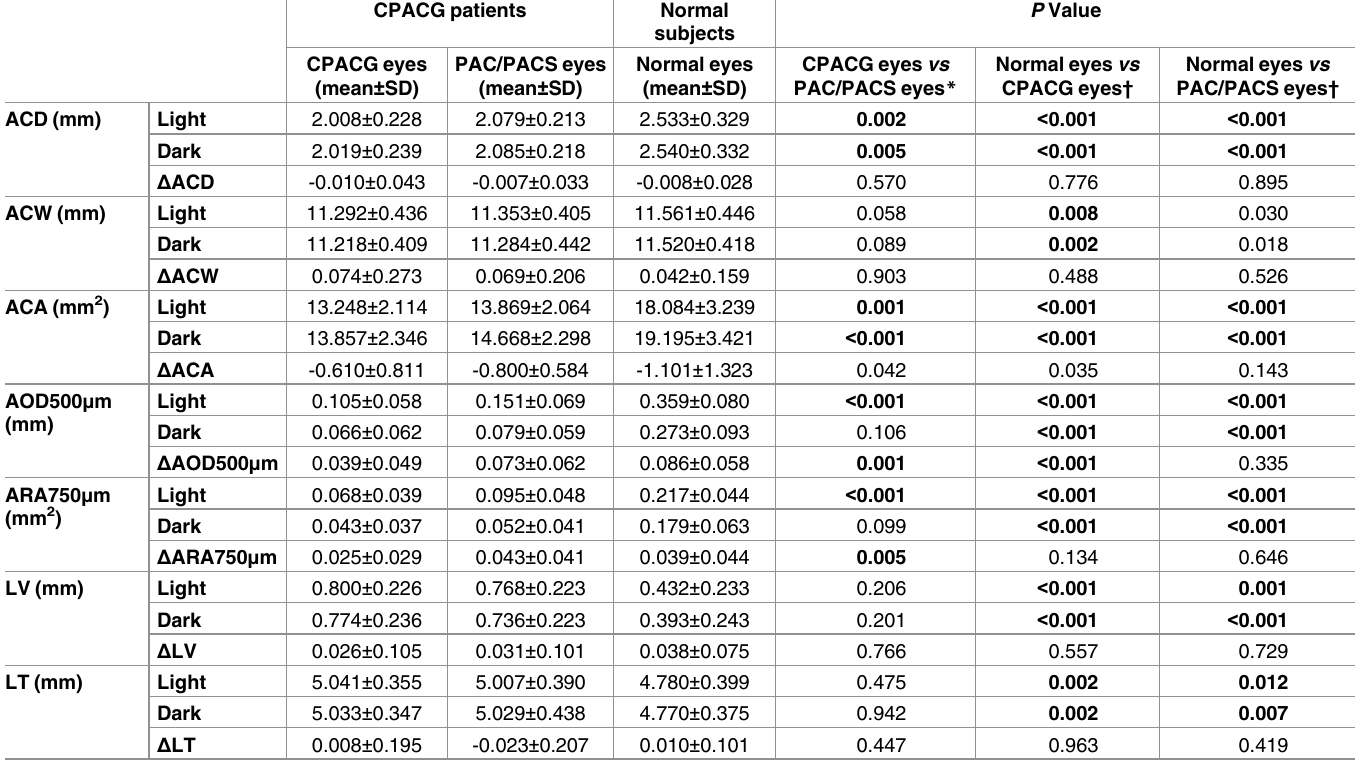
Table 2. Anterior segment parameters under light and dark conditions and light-dark changes ( Δ ) in CPACG patients (CPACG eyes vs fellow PAC/ PACS eyes) and normal subjects. CPACG